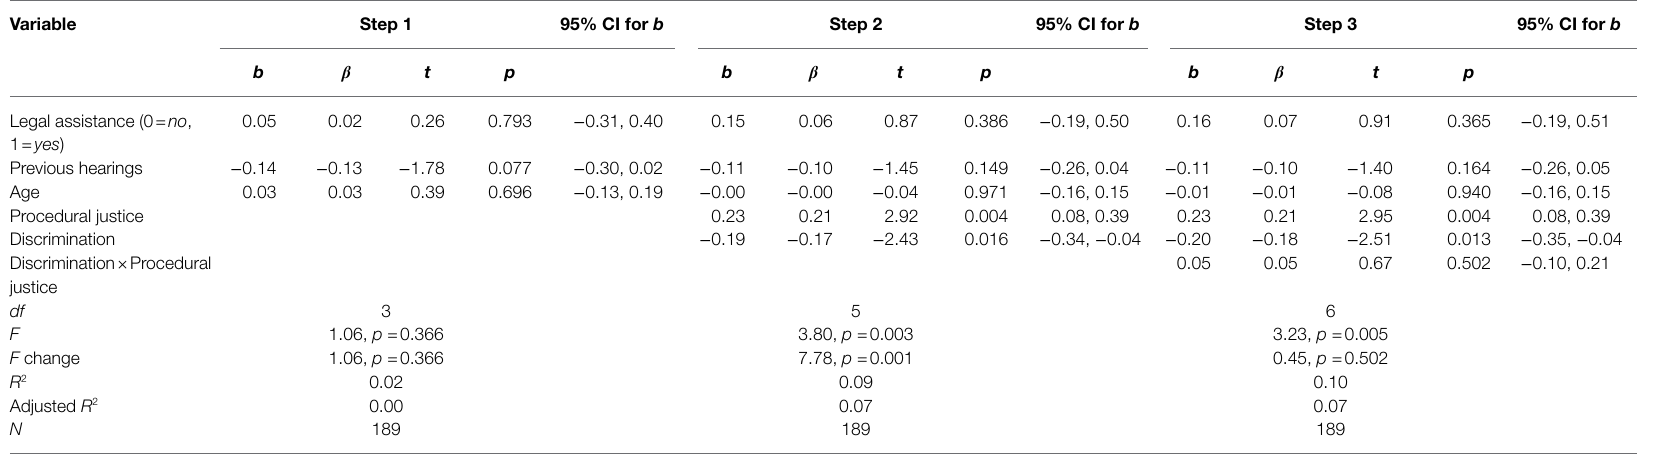
TABLE 10 | Regression results for procedural justice, discrimination, and their interaction on self-esteem. Variable Step 1